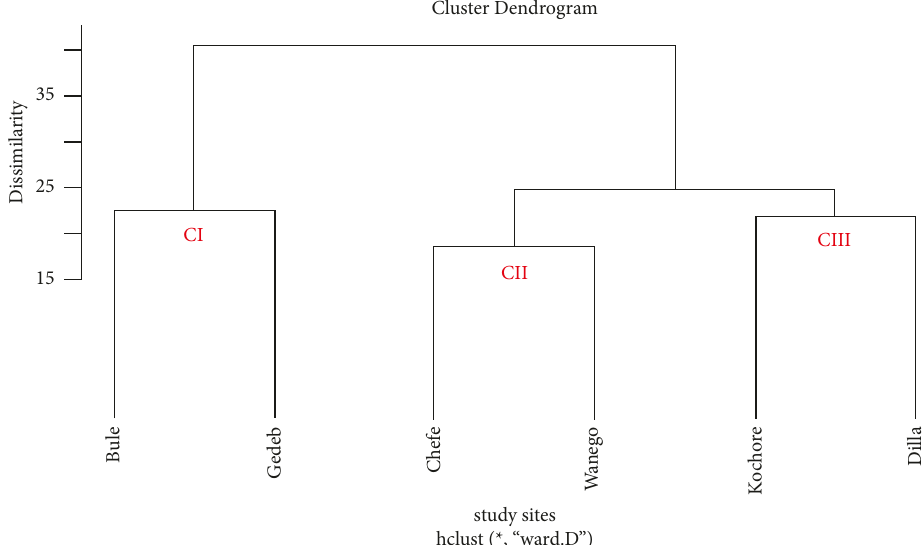
Figure 3: Cluster dendrogram of the major study woredas. Table 1: Species richness, evenness, and Shannon–Wiener diversity index of the plant community types. Community